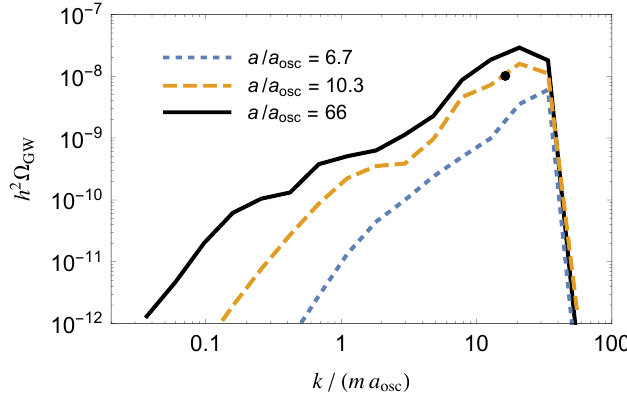
Figure 6 . Contribution to the GW spectrum at di(cid:11)erent times as parametrized by the scale factor. The blue dotted line corresponds to the large initial drop in the axion’s energy. The yellow dashed line gives the contribution up to the time where the tachyonic band is estimated to close, in good agreement with our analytic estimate from section 4. The solid black line gives the total spectrum after energy transfer has ended. The line styles and colors match the de(cid:12)nitions in (cid:12)gure 5. The plot uses the ALP 2 model parameters and the GW spectra were computed with N = 50